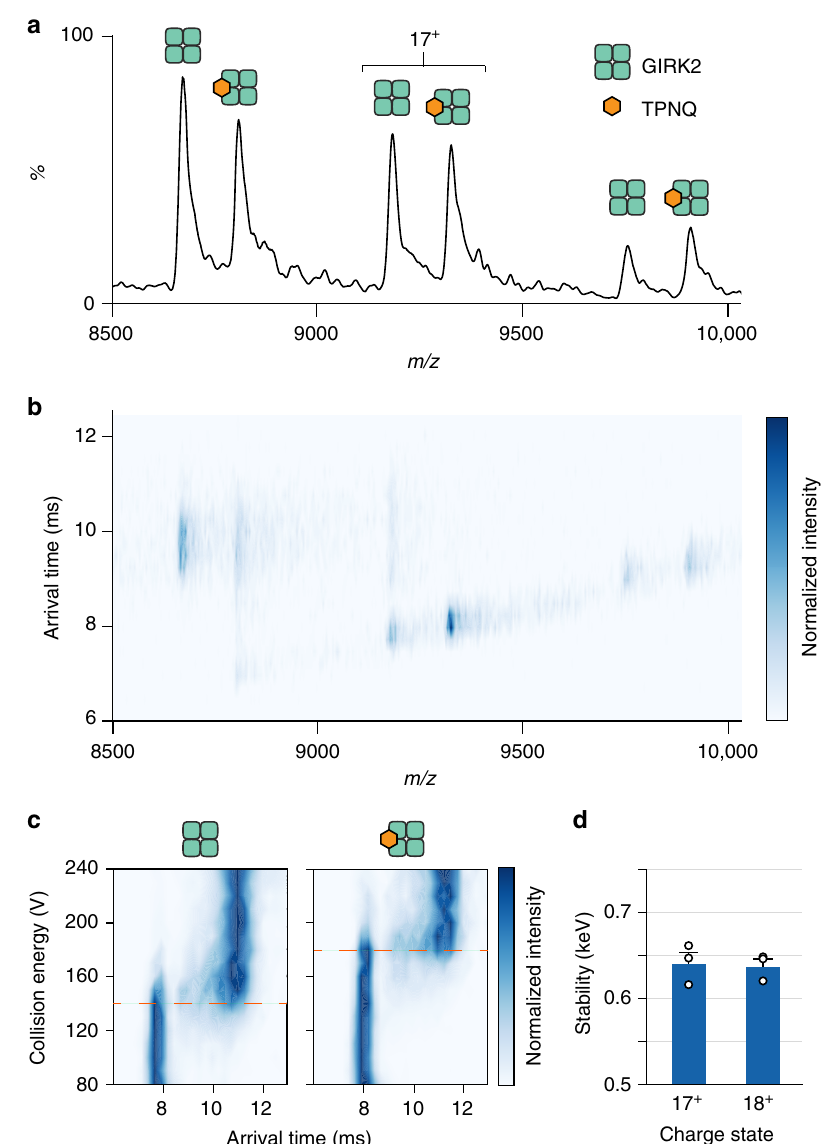
Fig. 2 Honey bee toxin, Tertiapin Q (TPNQ) binding and stabilization of GIRK2. a Mixture of GIRK2 and six molar equivalents of TPNQ in C 10 E 5 . One TPNQ binding event is observed in the mass spectrum. b Ion mobility mass spectrum indicates the 17 + charge state stabilizes the native-like state of the channel when bound to TPNQ. c Collision induced unfolding (CIU) plots for the 17 + charge state (left) apo and (right) TPNQ bound GIRK2. d Stabilization calculated from parameters de fi ned by fi tting GIRK2 (17 + and 18 + ) bound to TPNQ using the software program, PULSAR 32,55 . Reported are average and standard error of the mean (s.e.m.) from repeated measurements ( n = 3) in kiloelectron volts (keV). Source data are provided as a Source Data fi